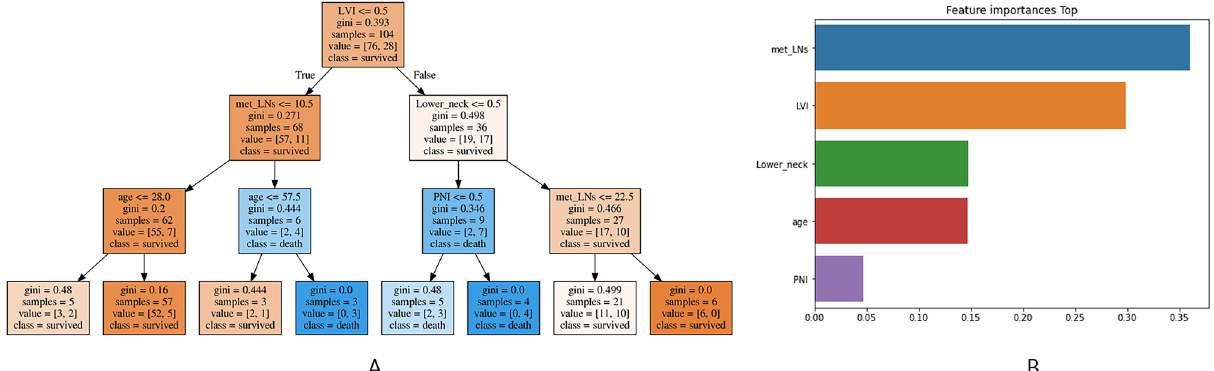
Figure 2. The structure of the decision tree model was visualized using graphic software. (The graph was made using by python version 3.8, scikit-learn version 12.3, and graphviz software, All these software are open-sourec program).